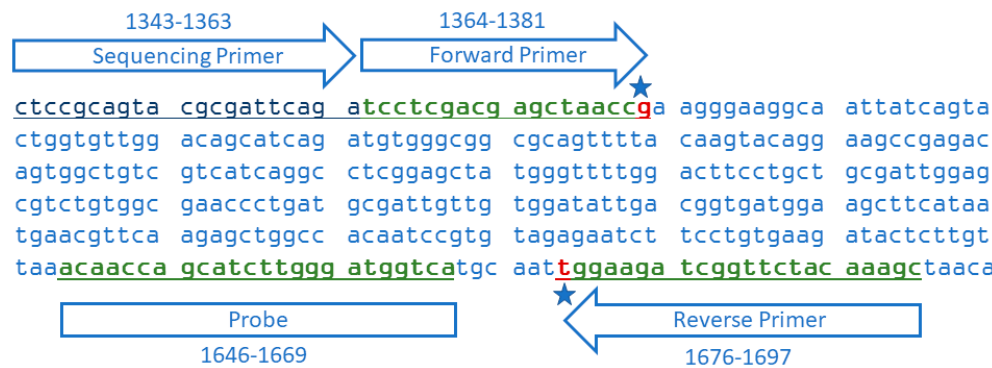
Figure 2. Portion of the Sanger sequencing of the segment of the AHAS1C gene spanning the site of genome editing, at position 1676, highlighted in blue. This base is homozygous G (wild type) in Clearfield canola variety 5545 CL, homozygous T (mutant) in SU canola variety 40K and G/T heterozygous in SU canola varieties C5507 and C1511. The region sequenced extended from AHAS1C -specific SNVs at positions 1363 and 1381 to beyond position 1704, verifying the location of the genome edit at position 1676. The location of the primer used for sequencing is indicated in Figure 3.